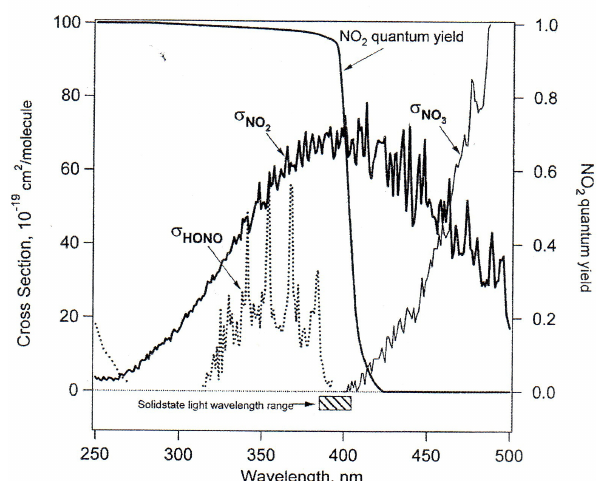
Fig. 2. BLC spectral information. The narrow wavelength range of the solid state LED’s avoids effects of interfering species (source: BLC instrument manual, Droplet measurement technologies,